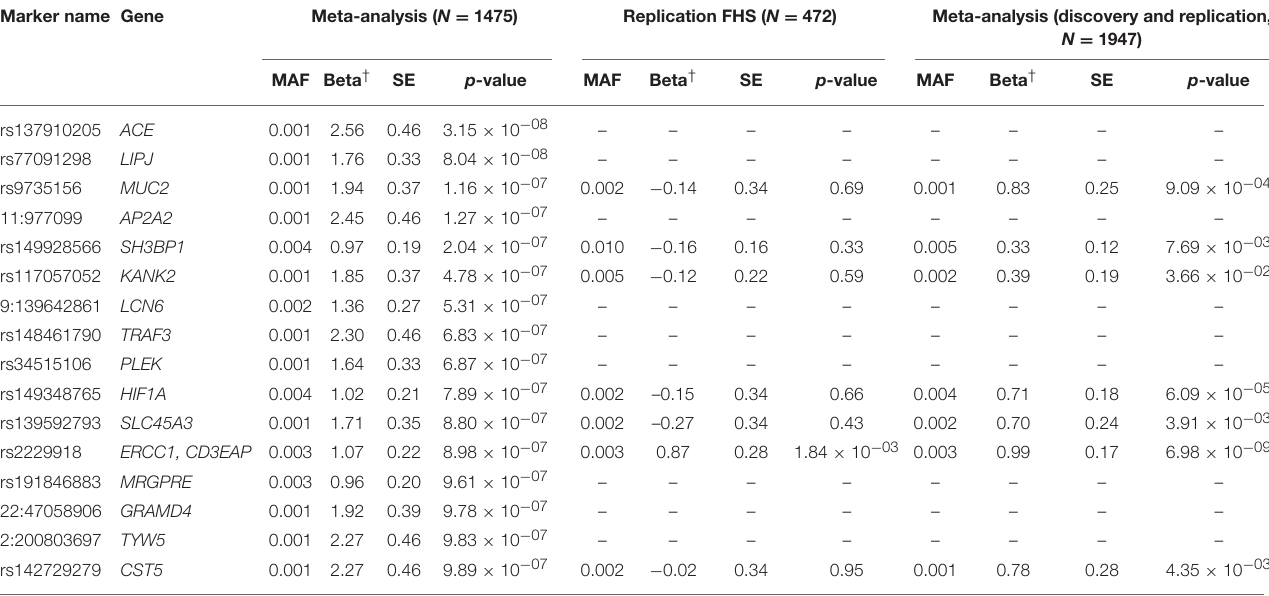
TABLE 4 | Replication results, filtered on p < 1.0 × 10 − 6